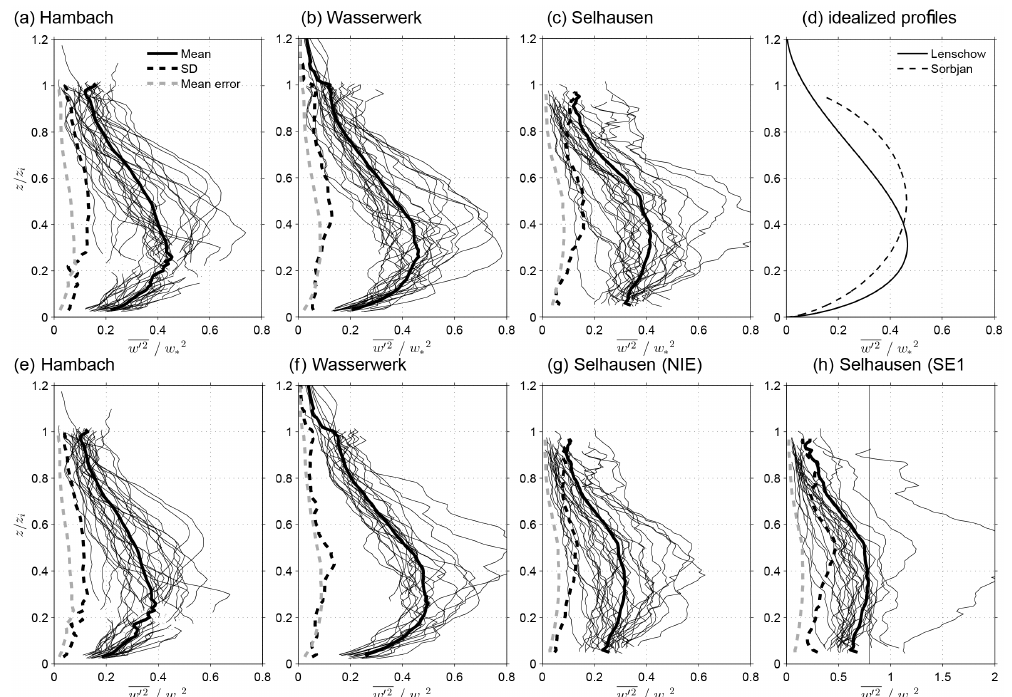
Figure 7. Normalized hourly variance profiles for 18, 20, 22, 24 April and 04 May (11:00–16:00UTC) with mean profile, standard deviation and mean normalized statistical error (legend in a ), using averaged (a, b, c) and local scaling (e, f, g, h) for each location; different energy balance stations were used for scaling the profiles of Selhausen in (g, h) ; in (d) , the idealized profiles according to Eq. 1 are